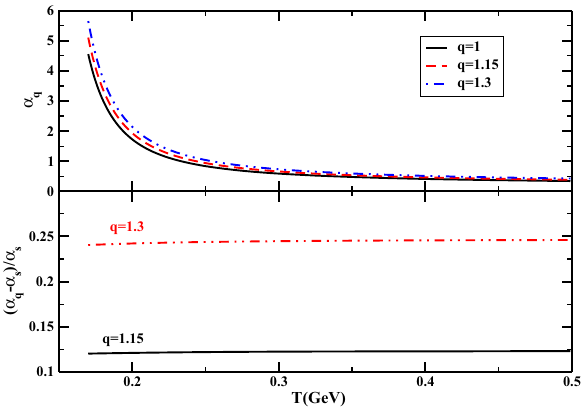
Fig. 7 TheQCDcouplinginanon-extensiveenvironmentasafunction of the temperature and its increment with respect to running